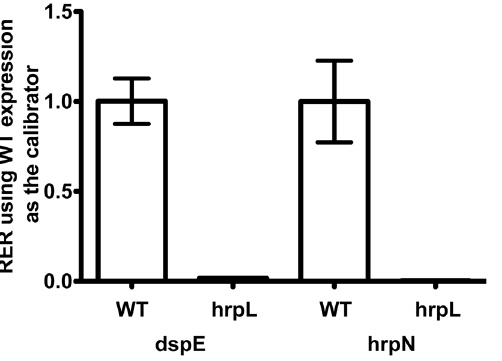
Figure 3. Inplanta expression of select P.carotovorum genes dspE and hrpL at 5 hpi. Relative expression of the dspE and hrpL transcripts in A. thaliana Col-0 leaves was determined with two validated reference mRNA ( recA and proC - Table S2). The mean relative expression ratio (RER) of the dspE and hrpN transcripts in the hrpL mutant was 0.017 and 0.003, respectively, compared to expression in the wild type strain. The mean normalized transcript abundance relative to reference mRNA was used as the calibrator. The difference in the RER means in the hrpL mutant compared to the wild type for both target transcripts was found to be significant at a 95% confidence interval by